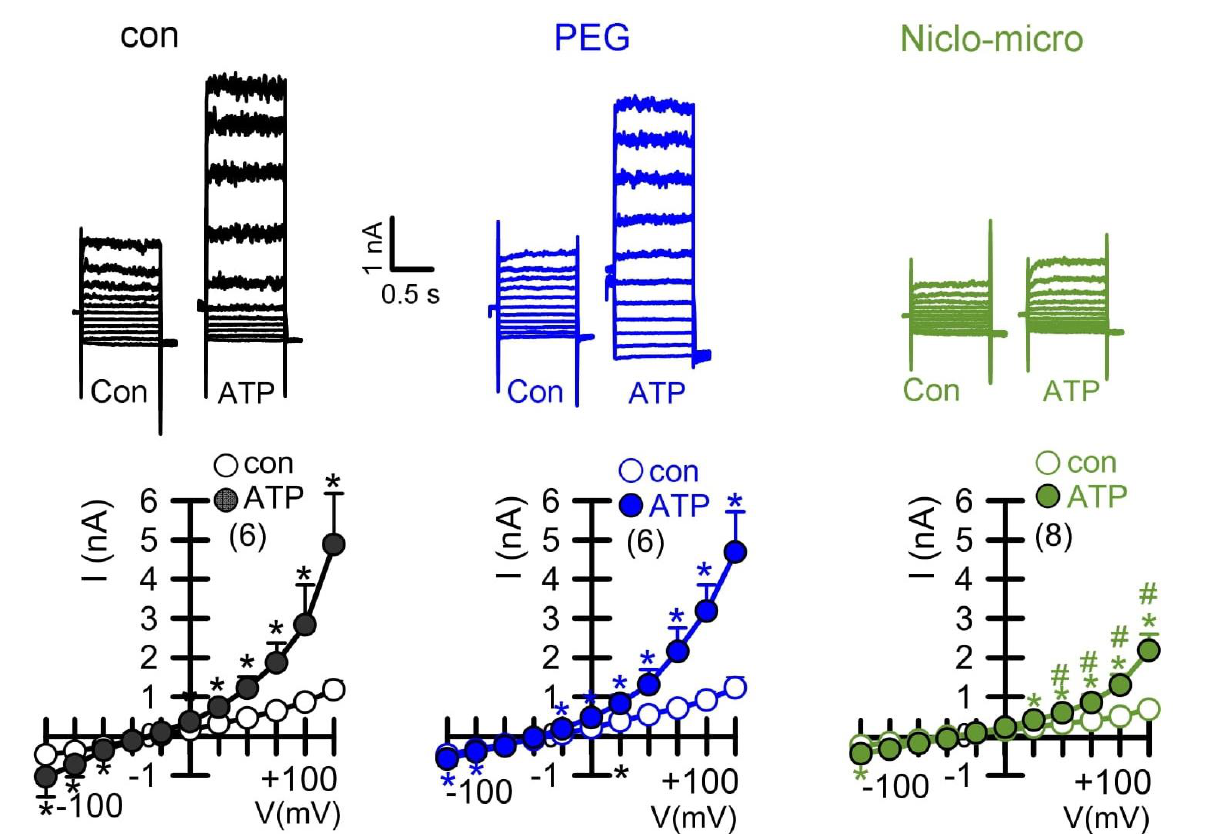
Figure 4. Activation of the Ca 2+ activated Cl − channel TMEM16A in CFBE human bronchial epithelial cells and inhibition by Niclo-spheres, but not by polyethylene glycol. Whole-cell current overlays (upper panels) and corresponding current/voltage relationships (lower panels). Activation of whole cell currents by purinergic stimulation (ATP; 100 µ M) in CFBE airway epithelial cells was comparable in non-treated control cells (con) and in cells exposed to empty polyethylene glycol microspheres (PEG), but was potently inhibited by microsphere-encapsulated niclosamide (Niclo-micro, 1 µ M). The inhibitor of Ca 2+ -activated KCNN4 K + channels, TRAM-34 (100 nM), was present in all patch clamp experiments to avoid unwanted activation of Ca 2+ activated K + channels. Mean ± SEM (number of cells). * significant activation by ATP ( p < 0.05; paired t -test). # significant difference when compared to con or PEG ( p < 0.05; unpaired t